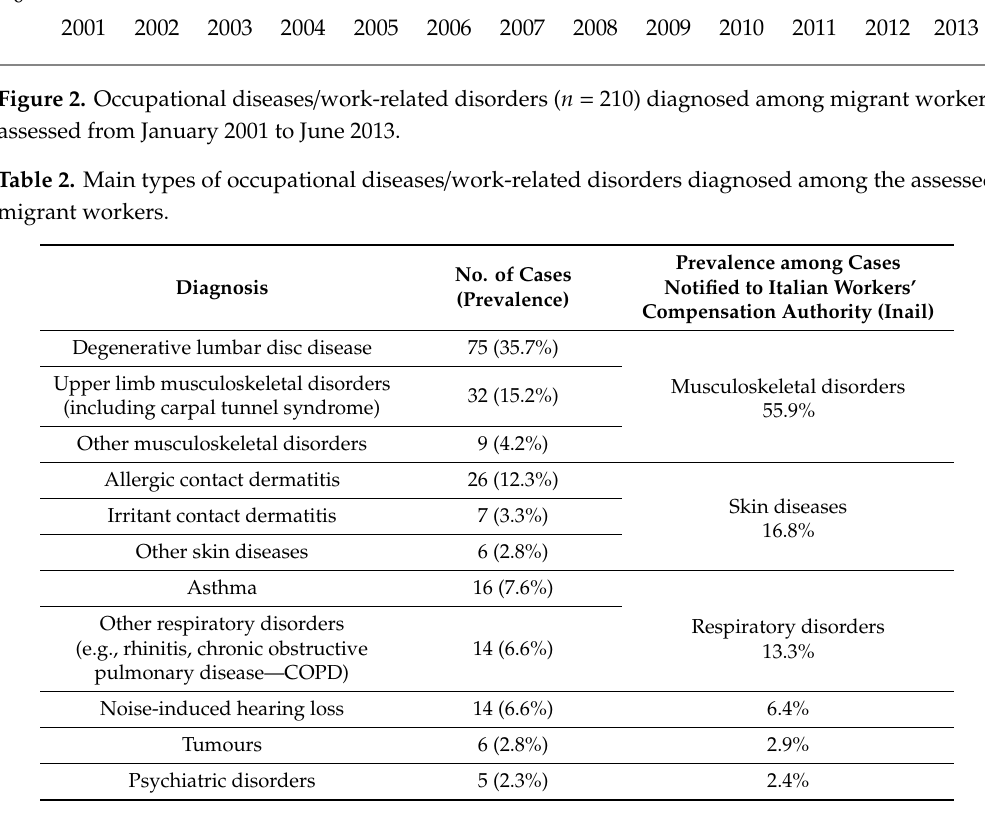
Table 3. Synopsis of the fitness-for-work evaluations performed among migrant workers from January 2001 to June 2013.